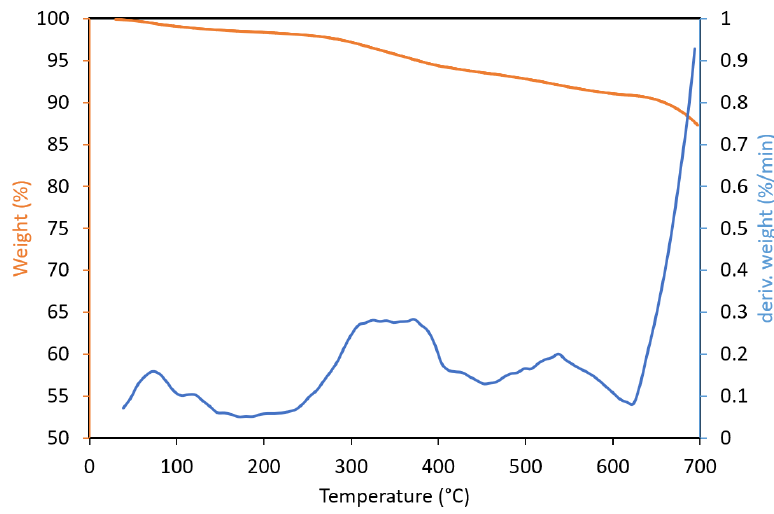
Figure 1. Thermogravimetric analysis of mussel shell residue .